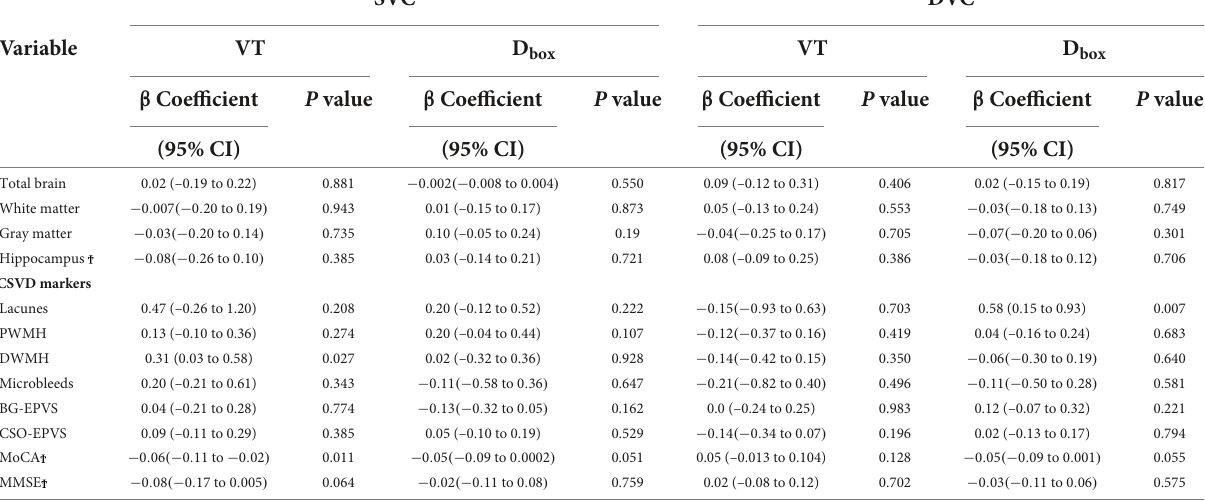
TABLE 2 Correlation between MRI parameters and OCTA